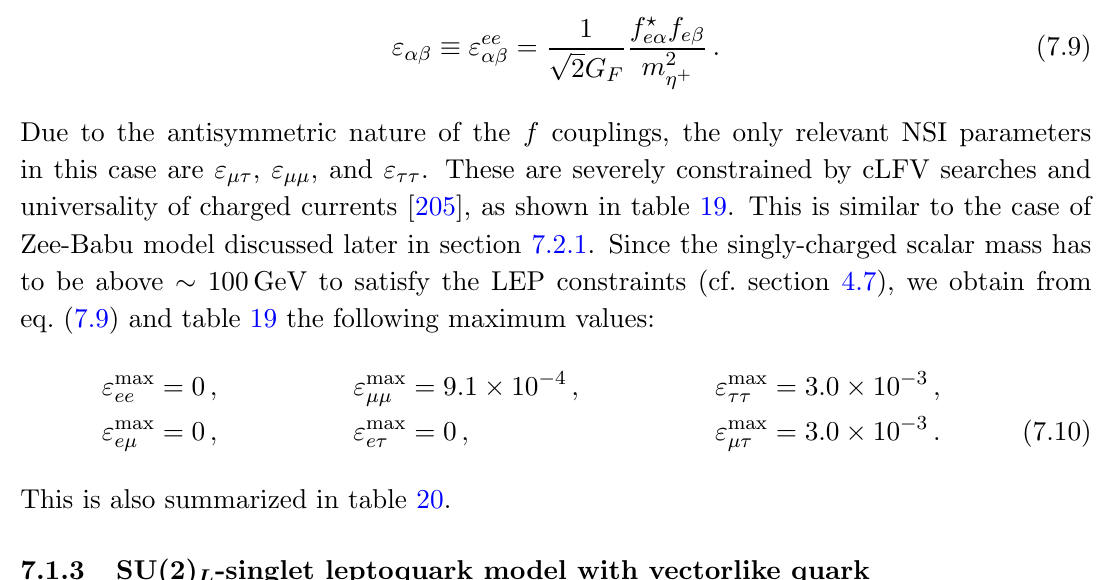
NSI in this model are induced by the f -type couplings in eq. (7.7), similar to the f -couplings in the Zee model Lagrangian (4.2). The NSI parameters read